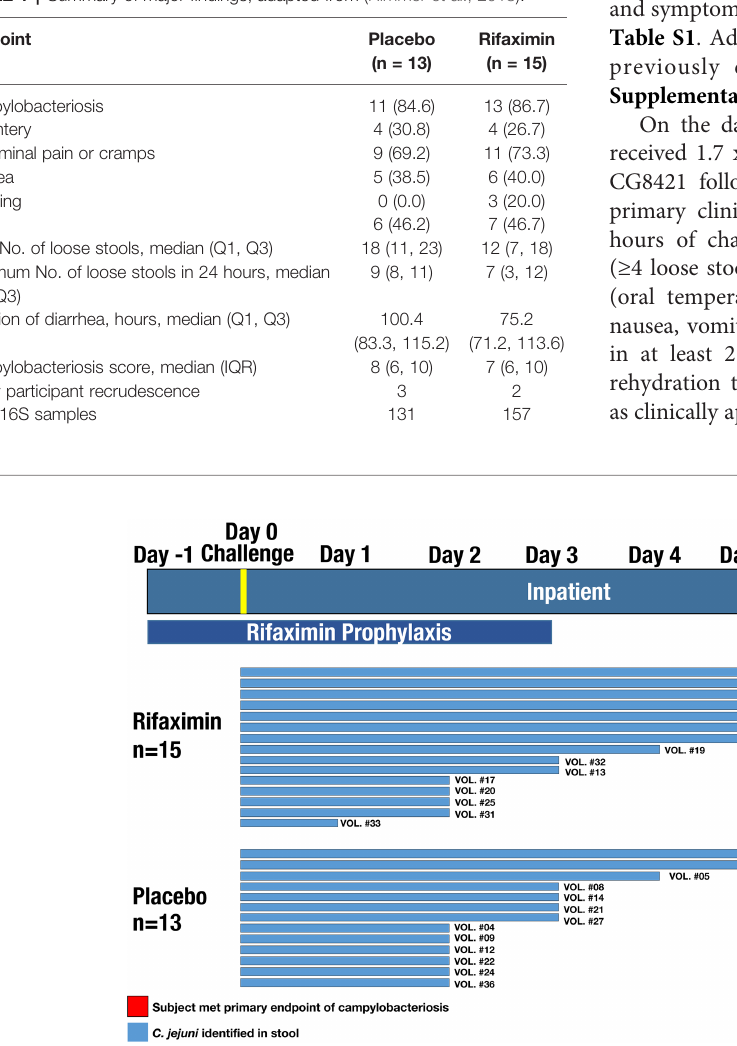
TABLE 1 | Summary of major fi ndings, adapted from (Rimmer et al., 2018).